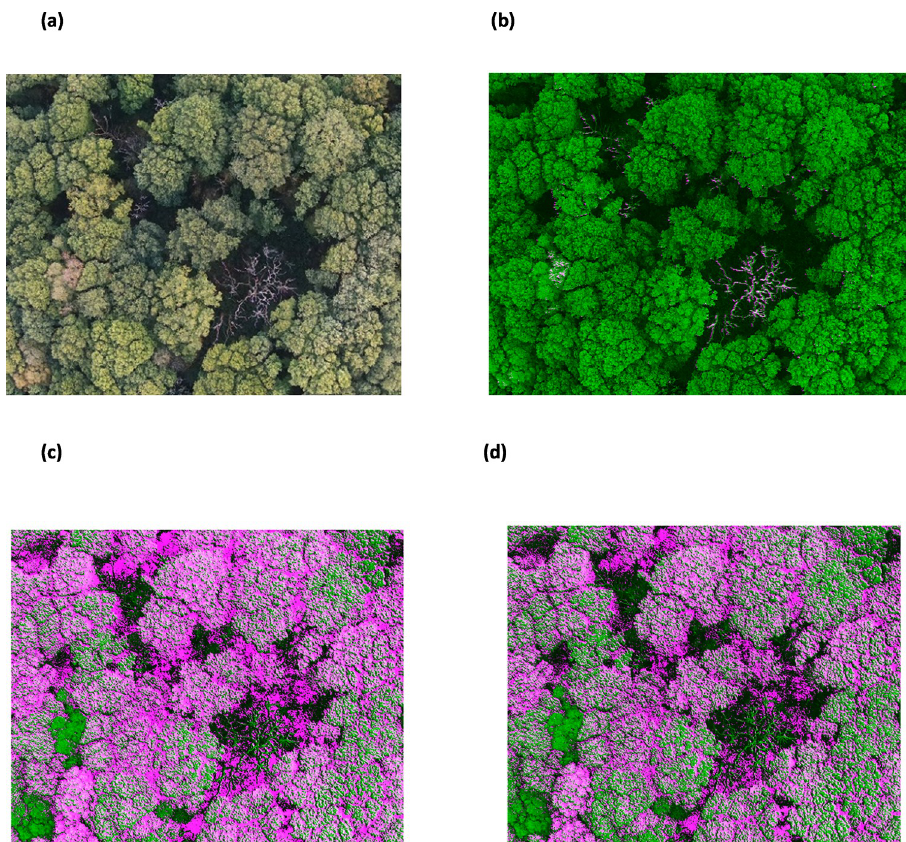
Fig 10. (a) RGB image outlining dead trees. (b) Image derived from new NDSI to differentiate dead trees after thresholding (14 October 2020) (c) NDVI image after thresholding (d) PCA NDVI image after